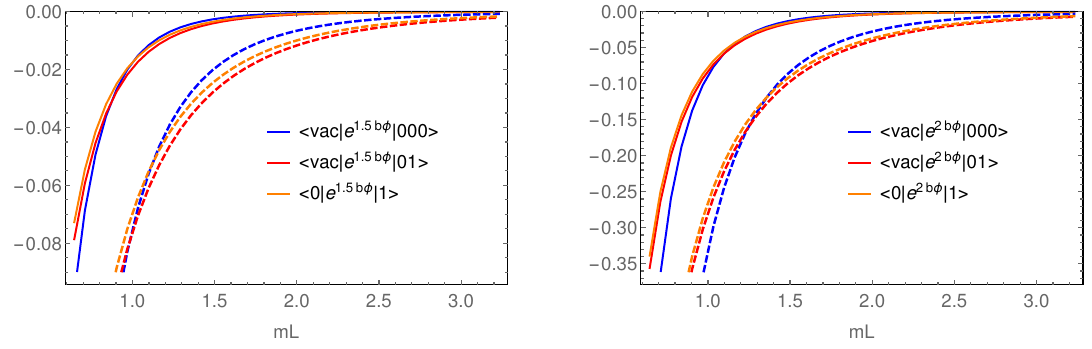
Figure 8 . Additional checks to some form factors of e 1 : 5 b’ and e 2 b’ in sinh-Gordon model. Poly- nomial (Pozsgay-Tak(cid:19)acs) results are depicted by dashed curves, while the results containing the (cid:12)rst exponential corrections, conjectured by the present article, are shown by continuous curves. Again, the TCSA results are subtracted from each data